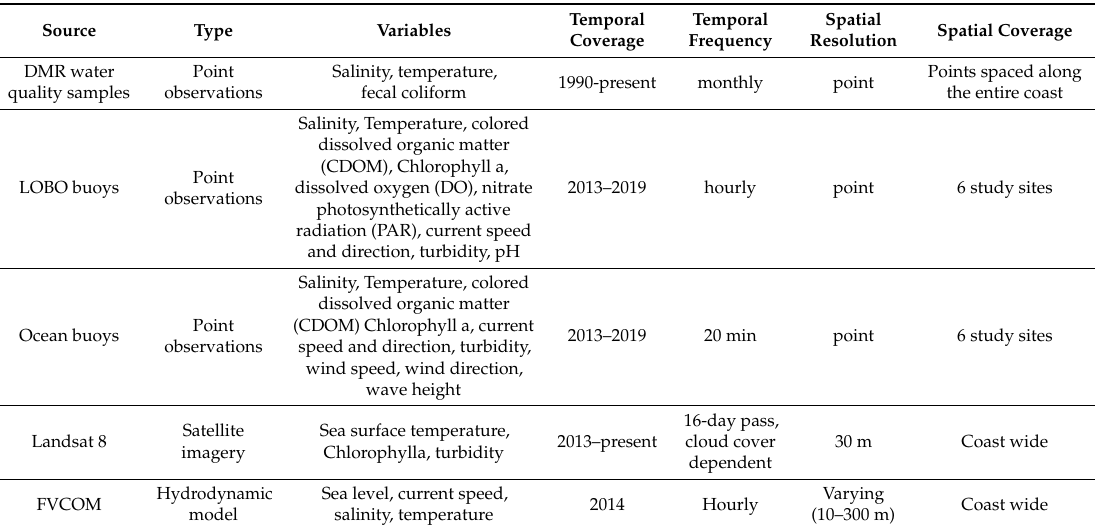
Table 2. Data sets used for characterizing Voronoi